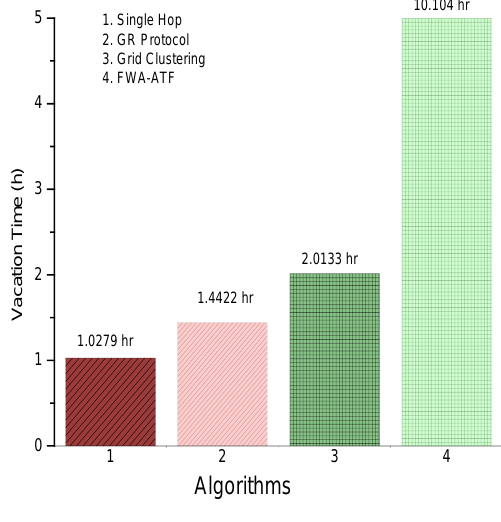
Figure 4. Vacation Time.